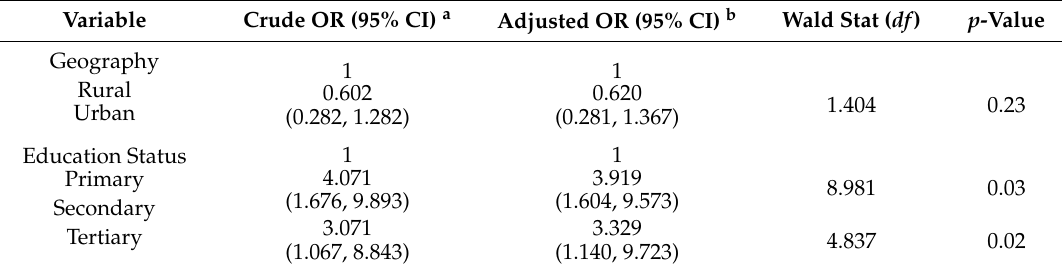
Table 4. Associated factors for positive attitude toward leptospirosis using multiple logistic regression ( N = 214).